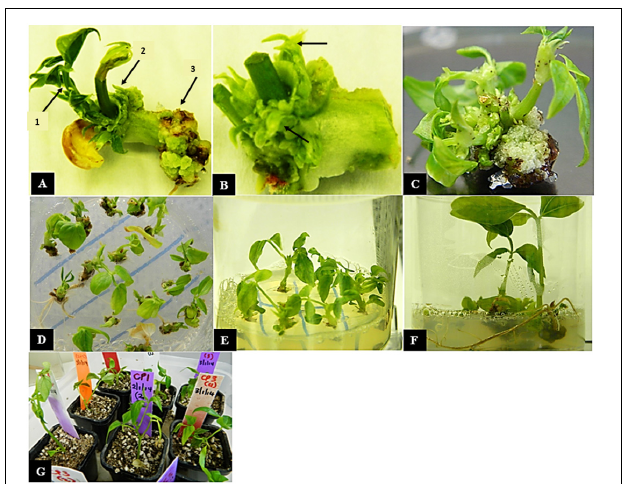
FIGURE 2 | In vitro regeneration of cowpea explants following co-cultivation with Agrobacterium . (A) Cowpea explant with cotyledon and primary shoots (arrow 1) on shoot induction medium (SIM) with selection at 2 weeks after co-cultivation, regenerated small buds (arrow 2) and callus (arrow 3) are visible (B) explant with cotyledon and primary shoot removed at 4 weeks leaving a clump with shoot buds (arrows) (C) multiple shoots formed on callus (D) multiple shoots separated onto SIM with 30 mg/L geneticin at 8 weeks (E) individual shoots grown with 30 mg/L geneticin at 10 weeks, (F) individual shoots rooting on elongation and rooting medium at 14 weeks and (G) rooted plantlets in soil at 16